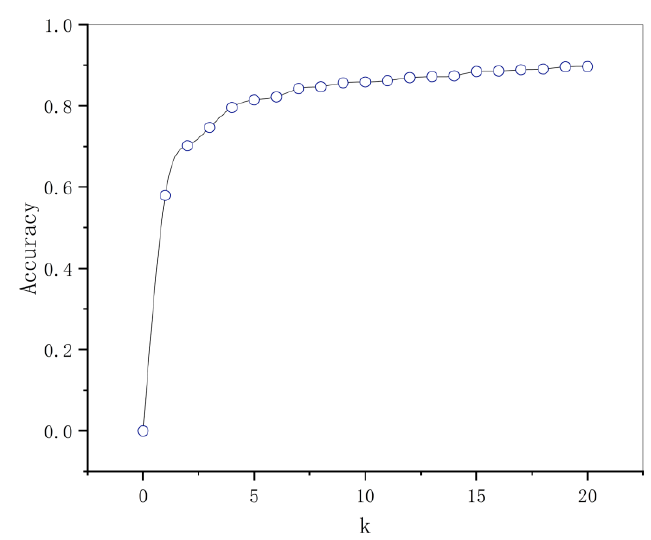
Figure 7. The relationship between the number of prior bounding boxes and accuracy. Table 4. Detection effect of plankton.